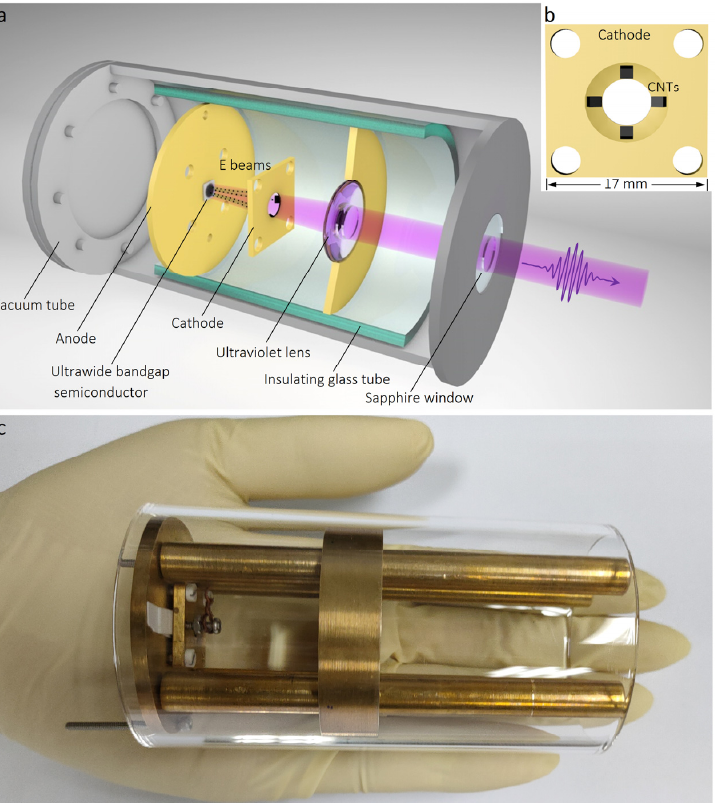
Figure 4. Ultraviolet cathodoluminescent device configuration. ( a ) Schematic diagram of the EB-pumping ultraviolet light emission setup. ( b ) Diagrammatic representation of cold cathode structure with four CNT cubes attached symmetrically. ( c ) A digital image of the ultraviolet cathodoluminescent device protype.